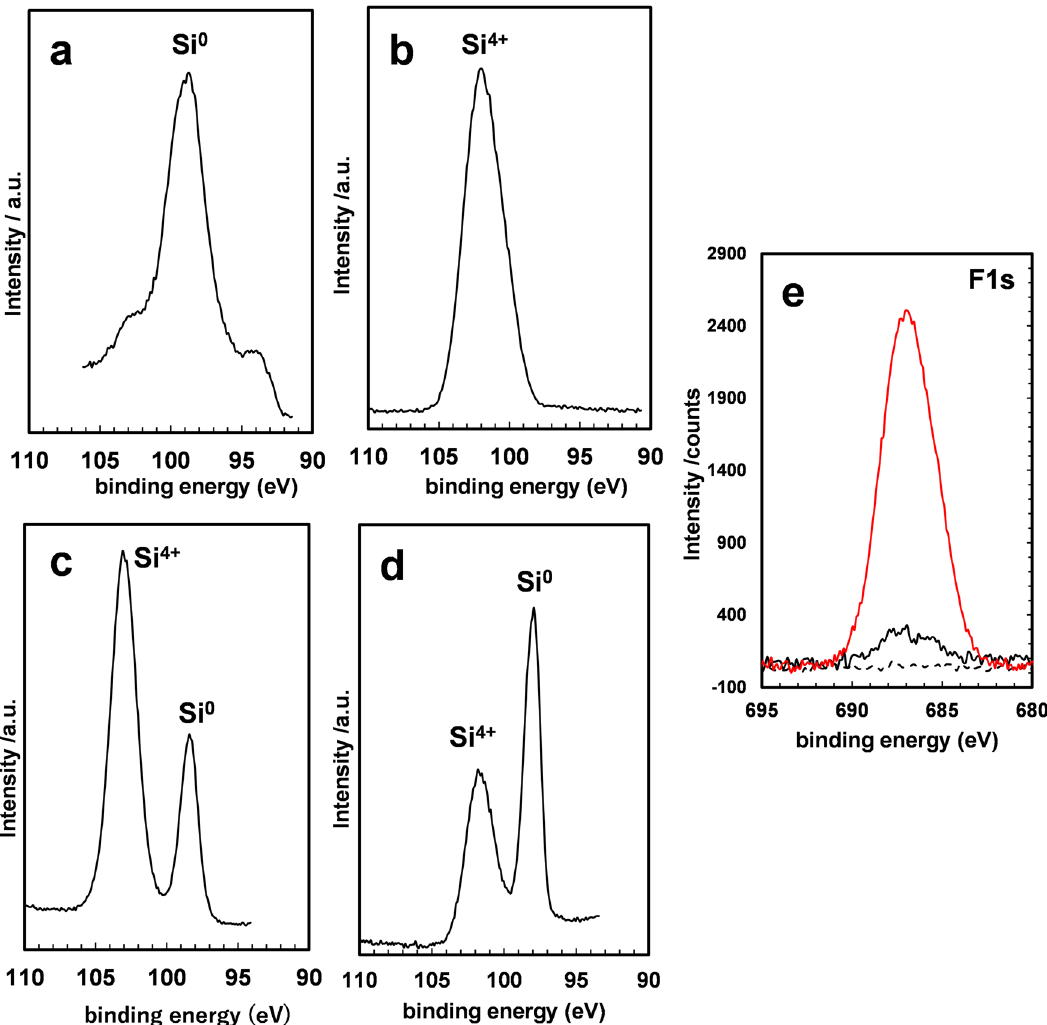
Fig. 5 XPS spectra of fresh silicon powder and recovered solid. Si2p region of the ( a ) fresh silicon powder, and ( b – d ) recovered solid after the catalysis, ( b ) with TBAF under CO 2 , ( c ) without TBAF under CO 2 , and ( d ) with TBAF under Ar. e XPS spectra of the F1s region of fresh silicon powder (black dotted line), recovered solid after catalysis (black solid line), and the solid after milling (red solid